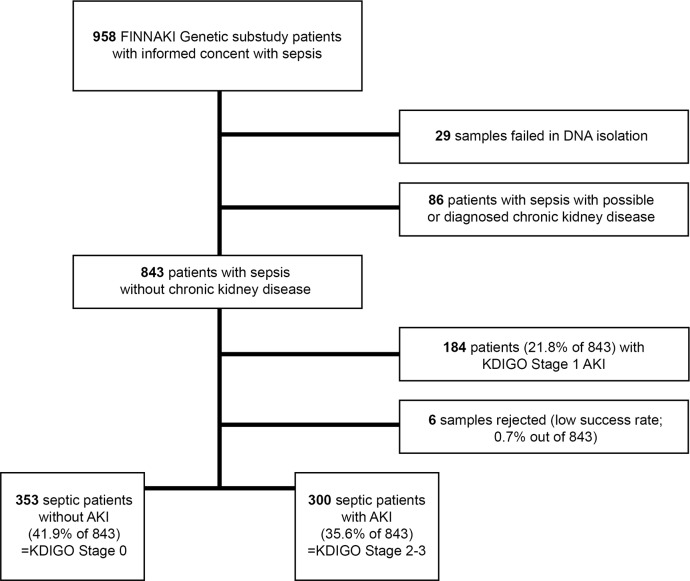
Study flow chart.Abbreviations: FINNAKI, Finnish acute kidney injury; DNA, deoxyribonucleic acid; KDIGO, Kidney Disease: Improving Global Outcomes; AKI, acute kidney injury.